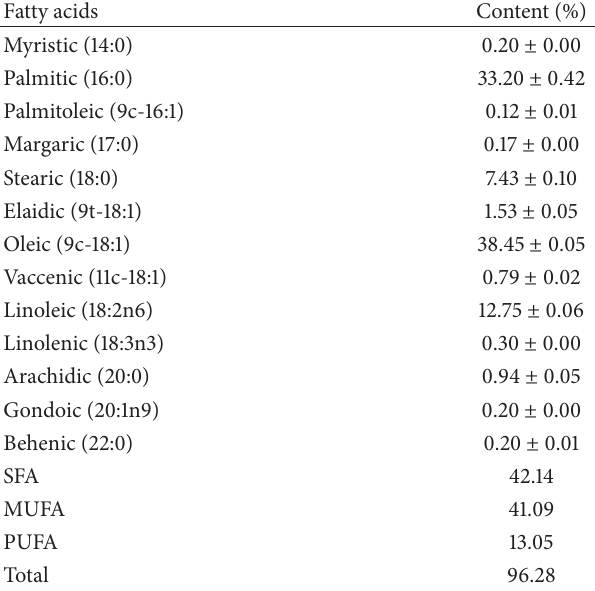
Table 3: Fatty acids content of Lannea kerstingii seed oil.